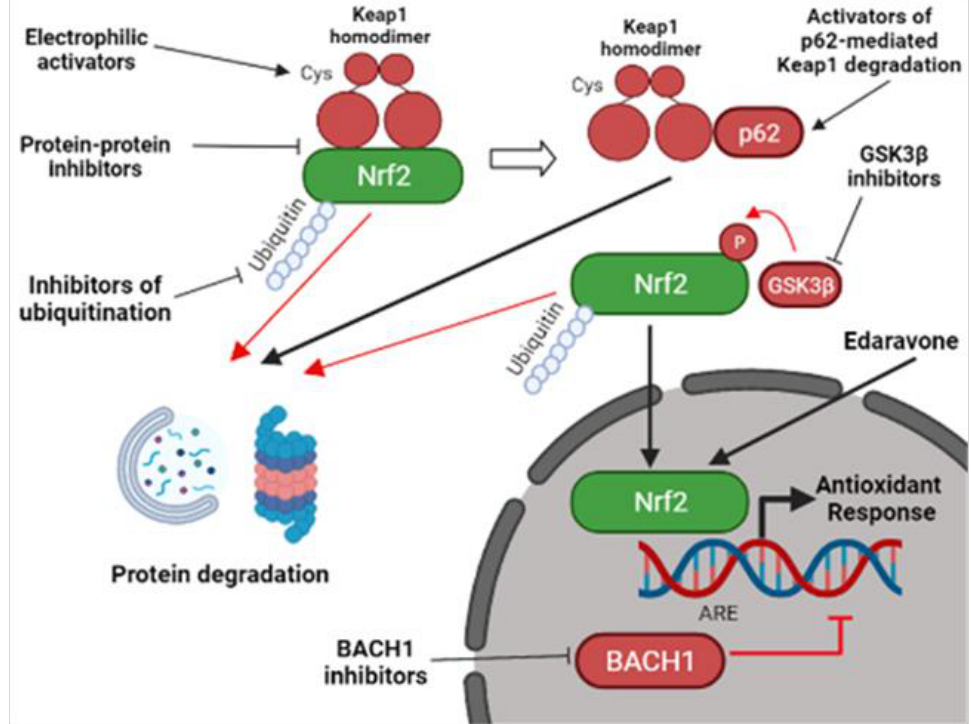
Figure 2. Pharmacological strategies to activate the Nrf2 pathway. Nrf2-activators do not usually target Nrf2 directly, but they function through the inhibition of different Nrf2-interactors. They can act by inhibiting Keap1-mediated Nrf2 degradation through the electrophilic modification of Keap1 cysteine residues or by interfering with the Nrf2-Keap1 protein-protein interaction. Other Nrf2-activators can promote Keap1 degradation by activating p62-mediated autophagy. Alternatively, Keap1-independent inhibitors can mediate Nrf2 activation. They include inhibitors of BACH1, an Nrf2-competitor for the ARE elements, inhibitors of GSK3 β , a kinase involved in Nrf2 degradation, and inhibitors of other proteins involved in Nrf2 ubiquitination [1,86]. Edaravone, a FDA-approved ALS compound, was also shown to activate Nrf2 [87], but the mechanism is still elusive. Nrf2, nuclear factor erythroid 2 – related factor 2; Keap1, Kelch-like ECH-associated protein 1; ARE, antioxidant responsive element; GSK3β, glycogen synthase kinase 3 beta; BACH1, BTB Domain And CNC Homolog 1 (created with BioRender.com, accessed on 27 January 2022).